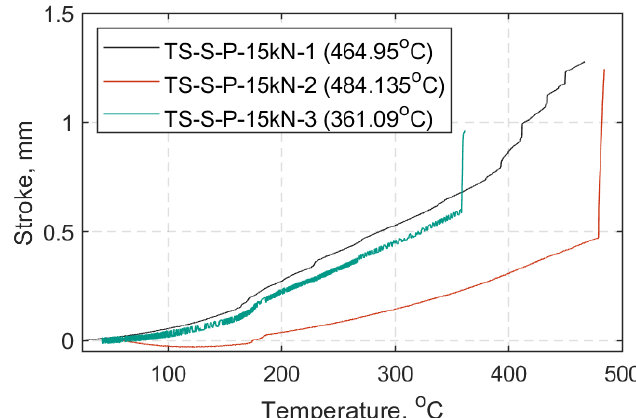
Figure 23. Crosshead stroke in hold mode (mm) vs. temperature (°C): All TS cases at 15 kN.